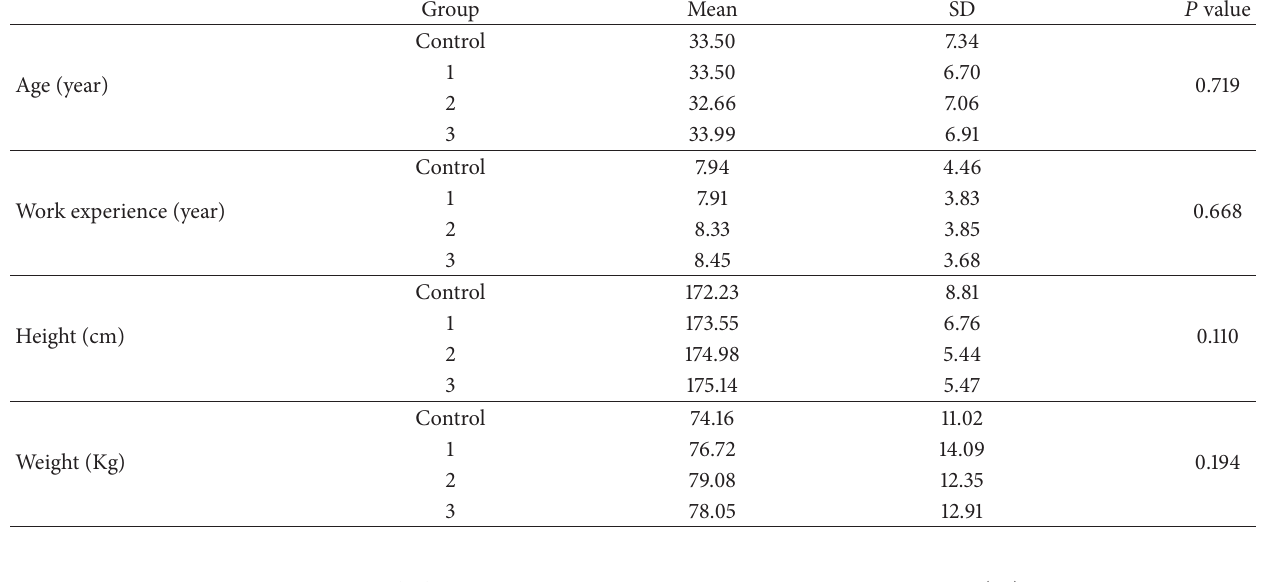
Table 1: Demographic properties of all workers in each job category.